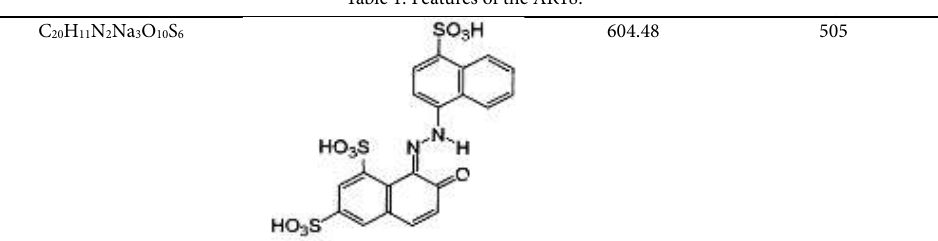
Table 1. Features of the AR18.